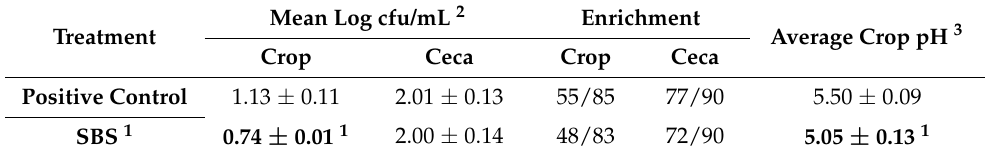
Table 2. Trial 2 colonization and incidence of crop and cecal contents and average crop pH.